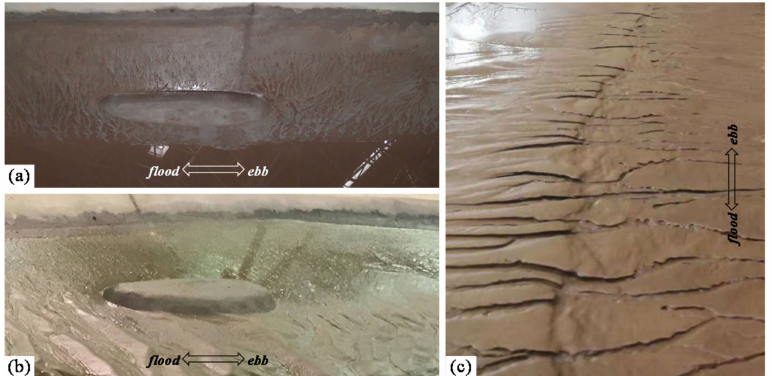
Figure 10. The typical morphological patterns used in the experiment. ( a ) A tidal rill structure after 20 tidal cycles, ( b ) the channel network structure at the end of the experiment, and ( c ) the local morphology of the tidal channel network.